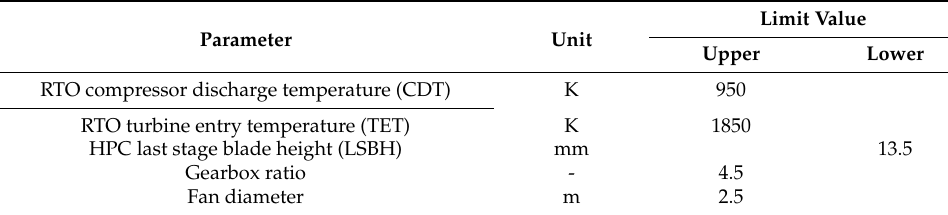
Table 2. Optimization